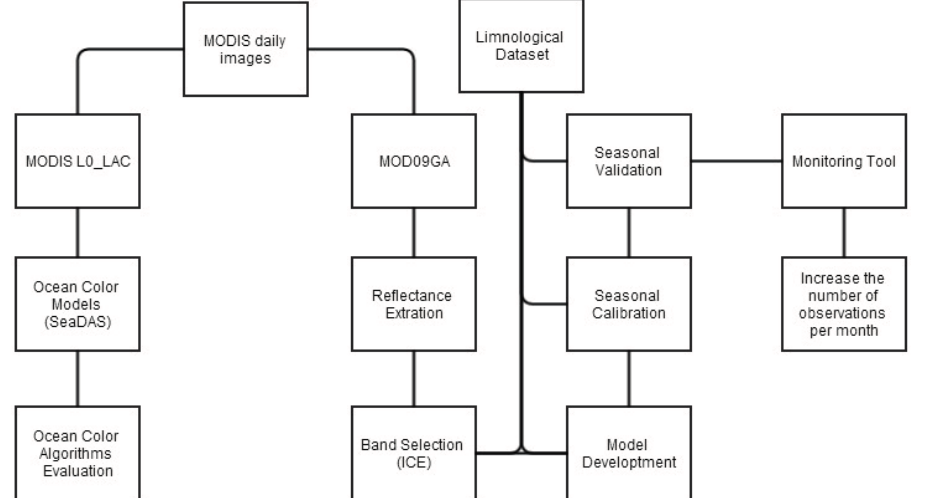
Figure 2. Flow chart of the methodology used to develop an empirical model for chl- a estimation in Lake Thonotosassa. SeaDAS, normalized bias; ICE, Interactive Correlation